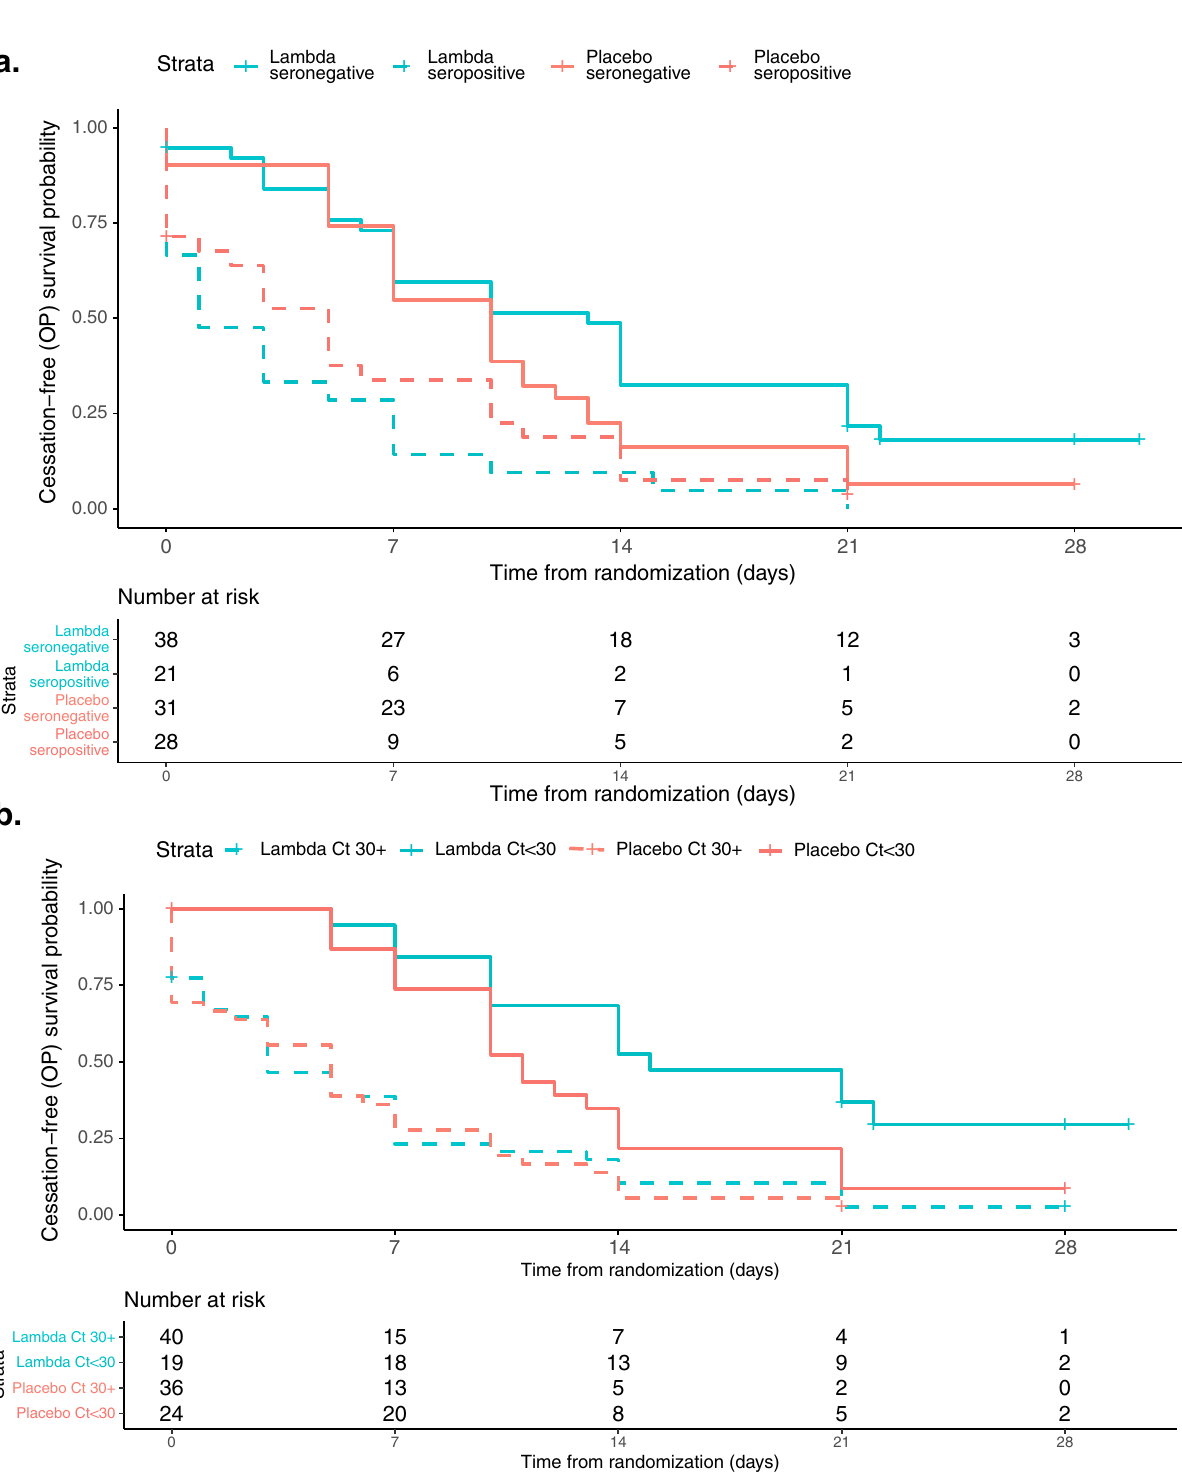
Fig. 3 Kaplan – Meier analyses of the primary outcome, strati fi ed by baseline seropositivity and viral load. a Time until cessation of SARS-CoV-2 viral shedding from oropharyngeal swabs strati fi ed by baseline SARS-CoV-2 seropositivity, seropositive (dashed) and seronegative (solid), and treatment arm, Lambda (blue) vs. placebo (red). b Time until cessation of SARS-CoV-2 viral shedding from oropharyngeal swabs strati fi ed by baseline SARS-CoV-2 oropharyngeal virus CT value, CT value ≥ 30 (dashed) and CT value < 30 (solid), and treatment arm, Lambda (blue) vs. placebo (red). In both panels, solid lines represent Kaplan – Meier survival probability; shading represents 95% con fi dence intervals. Source data available at https://purl.stanford.edu/